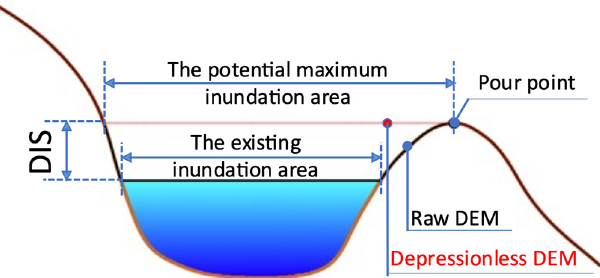
Figure 2. The conceptual figure for the presentation of the characteristics of the open-water wetland on the DEM.